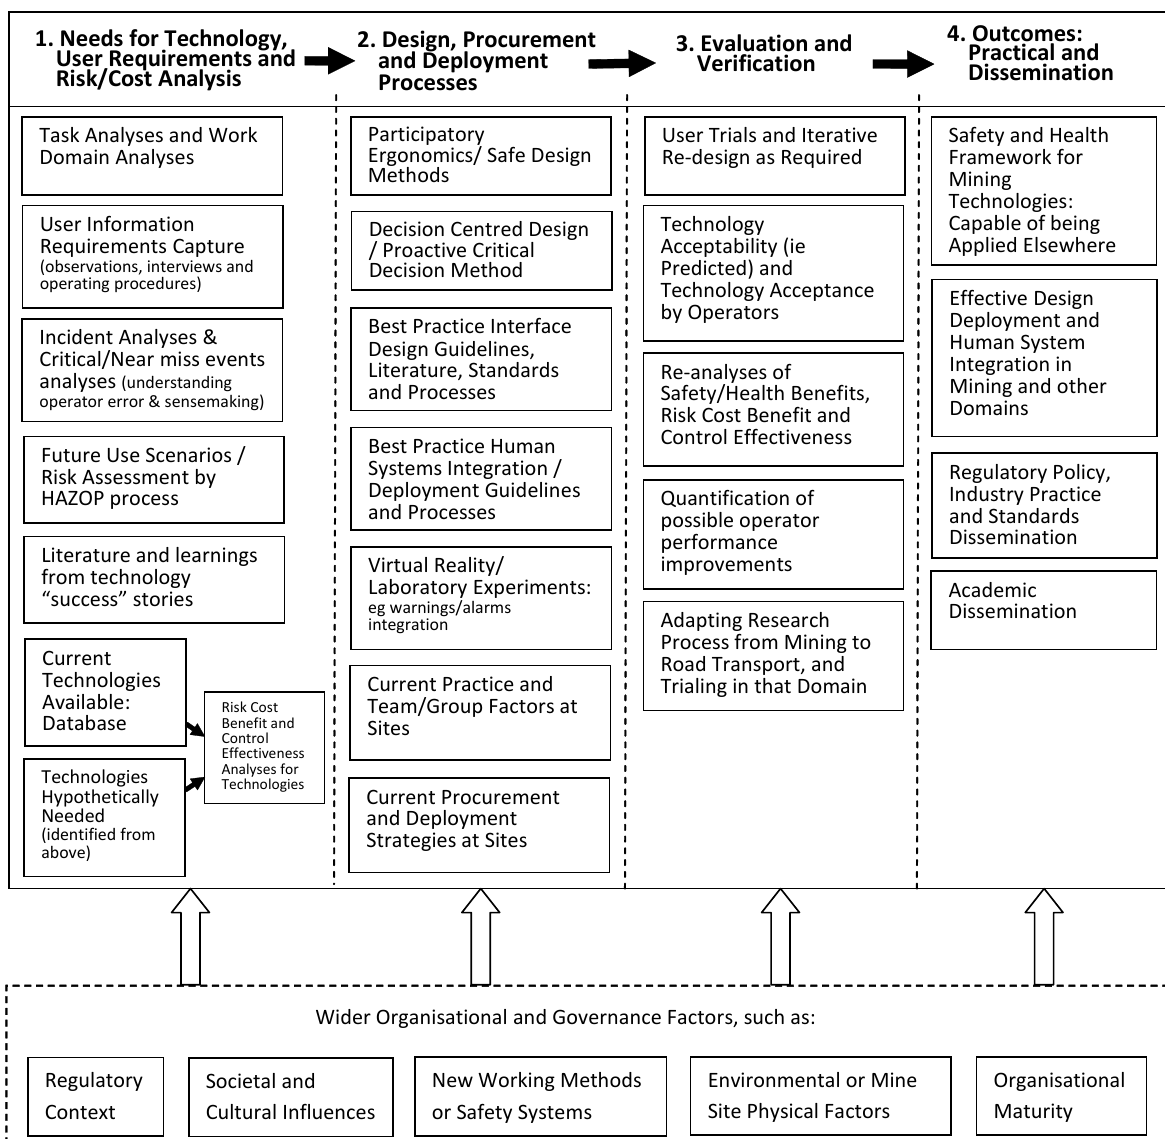
Figure 1 . Strategy